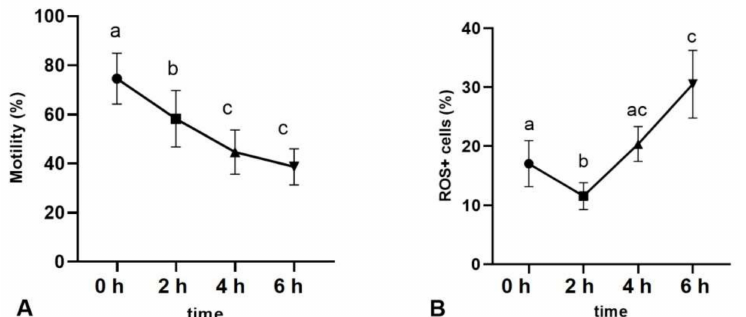
Figure 5. Total sperm motility (%) ( A ) and ROS-positive spermatozoa content (%) ( B ) after 0, 2, 4 and 6 h of incubation in capacitation-supporting conditions. Different letters indicate significant differences ( p < 0.05) among timepoints. Data are expressed as the mean ± SEM ( n = 8).